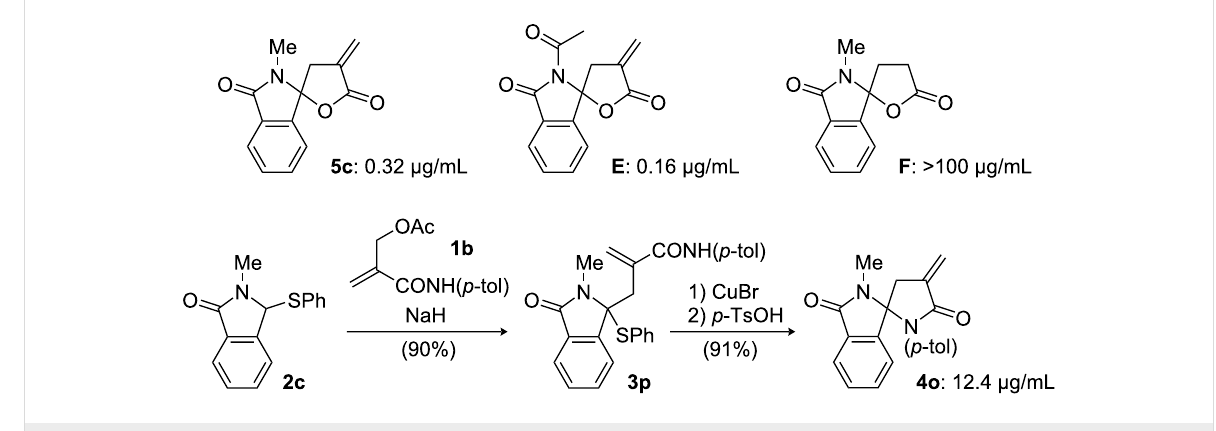
Figure 2: Cytotoxicity of spirolactams on P388 cells (IC 50 values).